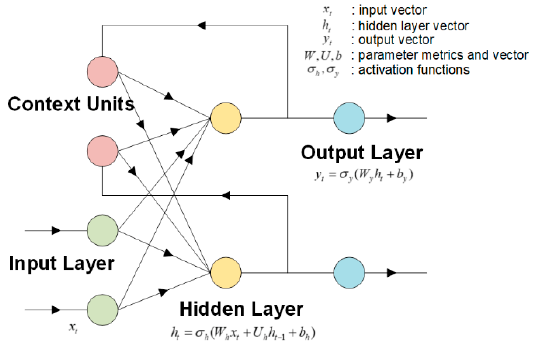
Figure 13. Principle of the Elman neural network.